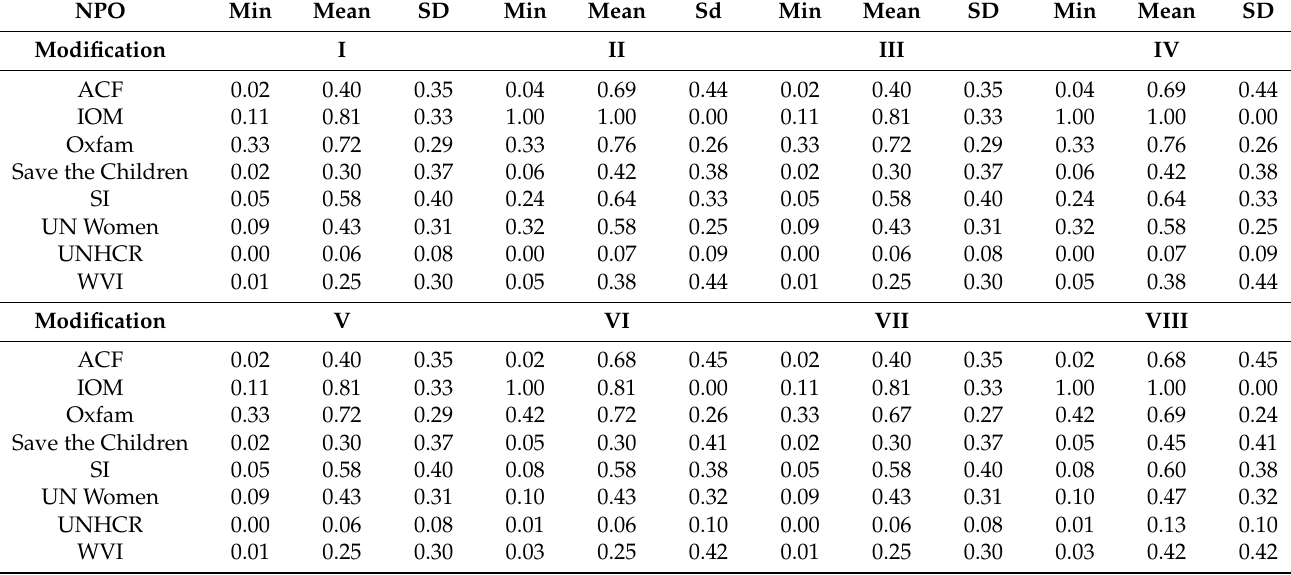
Table 8. Results for DEA model for NPO/NGO per